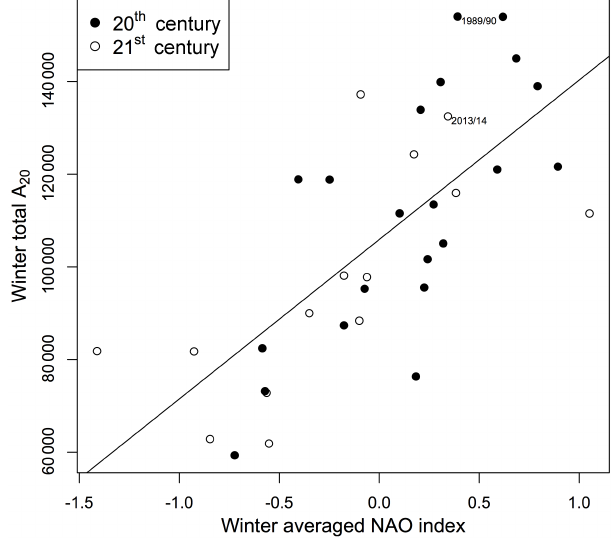
Figure 7. Relationship between winter total A 20 and winter- averaged NAO index for October–March winters 1979/1980– 2013/2014. The linear fit ( y ∼ x ) is shown (solid line). The two comparative periods, winters in the 20th century and winters in the 21st century, are indicated. The points associated with win- ters 1989/1990 and 2013/2014, discussed in the Introduction, are